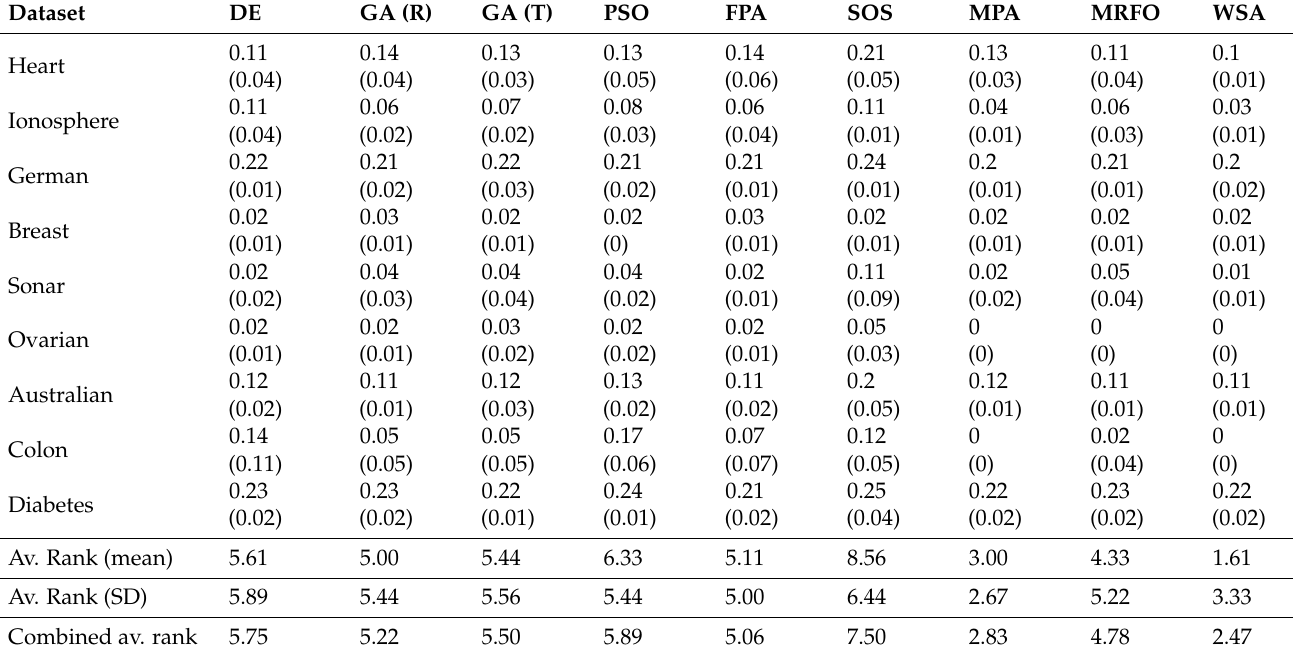
Table 4. Mean (and standard deviation) of best fitness value achieved by each algorithm for each dataset on repeated